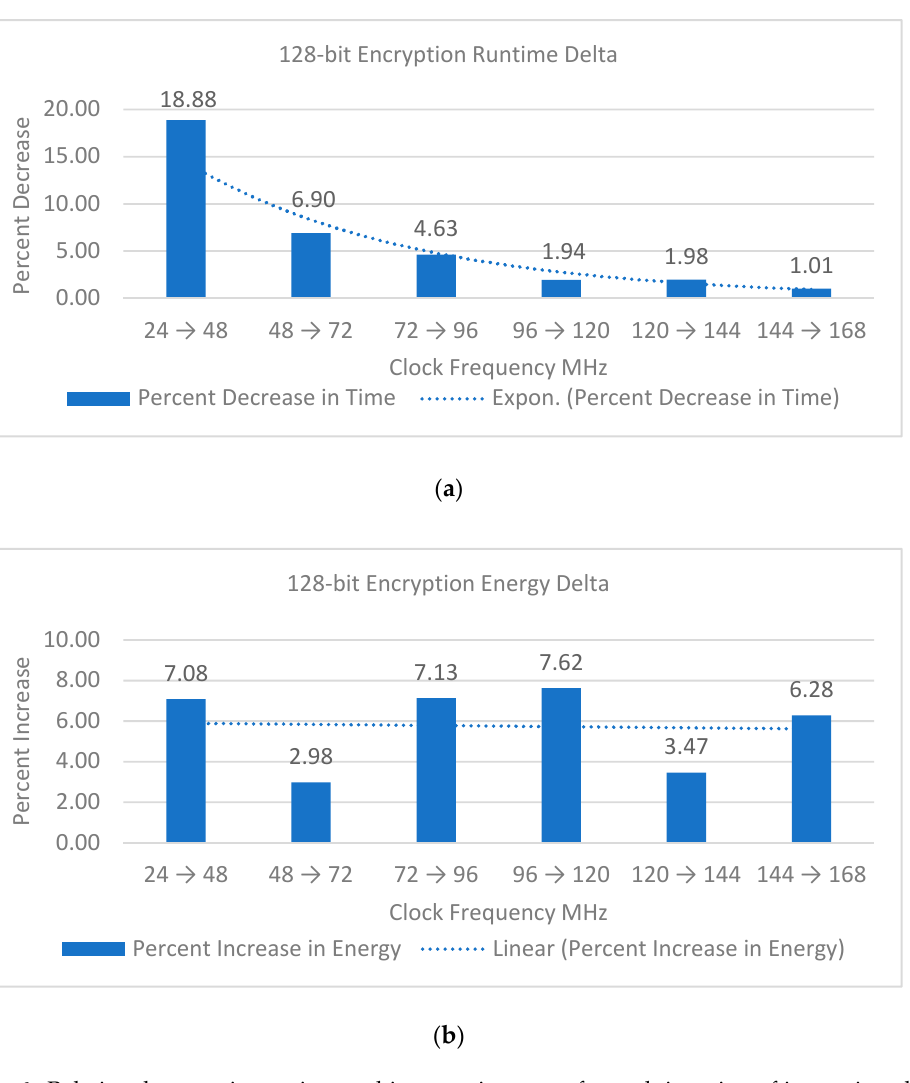
Figure 6. Relative decrease in runtime and increase in power for each iteration of increasing clock frequency: ( a ) percent decrease in runtime shows diminishing returns as further increases in clock frequency cease to yield significant reduction in runtimes; ( b ) percent increase in power shows consistent change. A preference of operating at 72 MHZ and / or 144 MHZ is developed as these frequencies yield the lowest relative increase in energy over the next slower frequency.